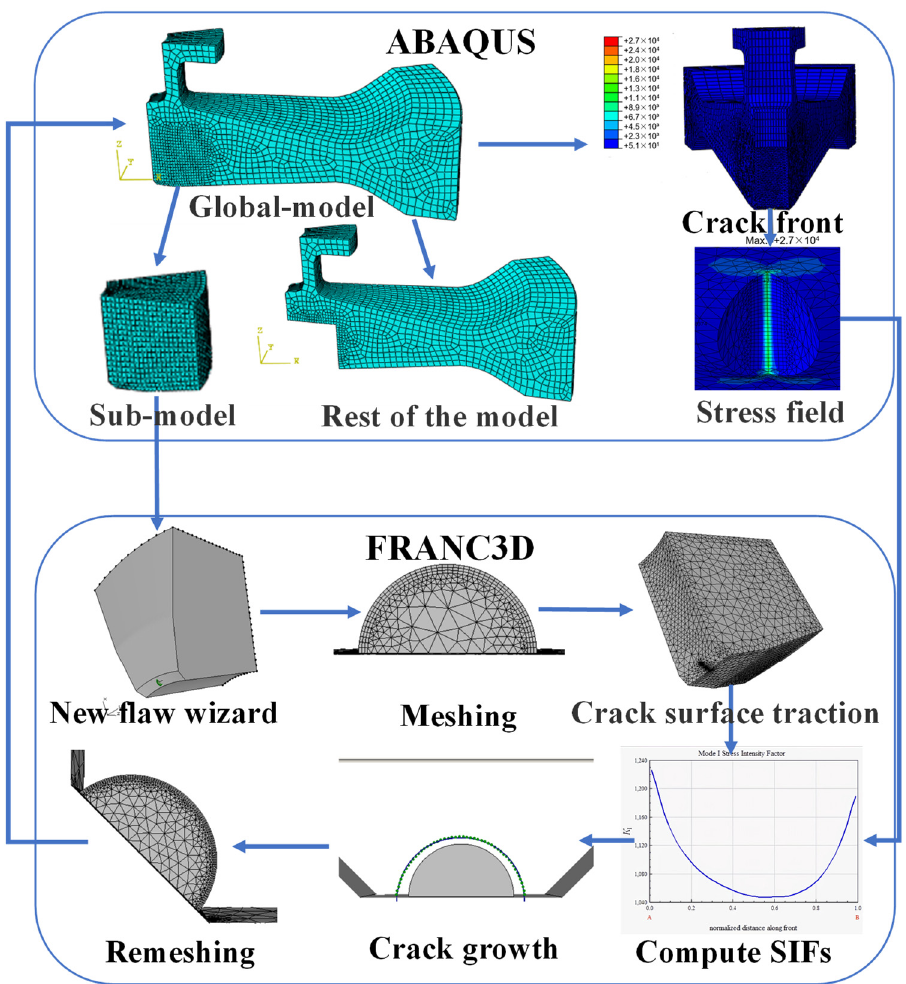
Figure 23. Calculation of crack growth rate by using ABAQUS and FRANC3D.